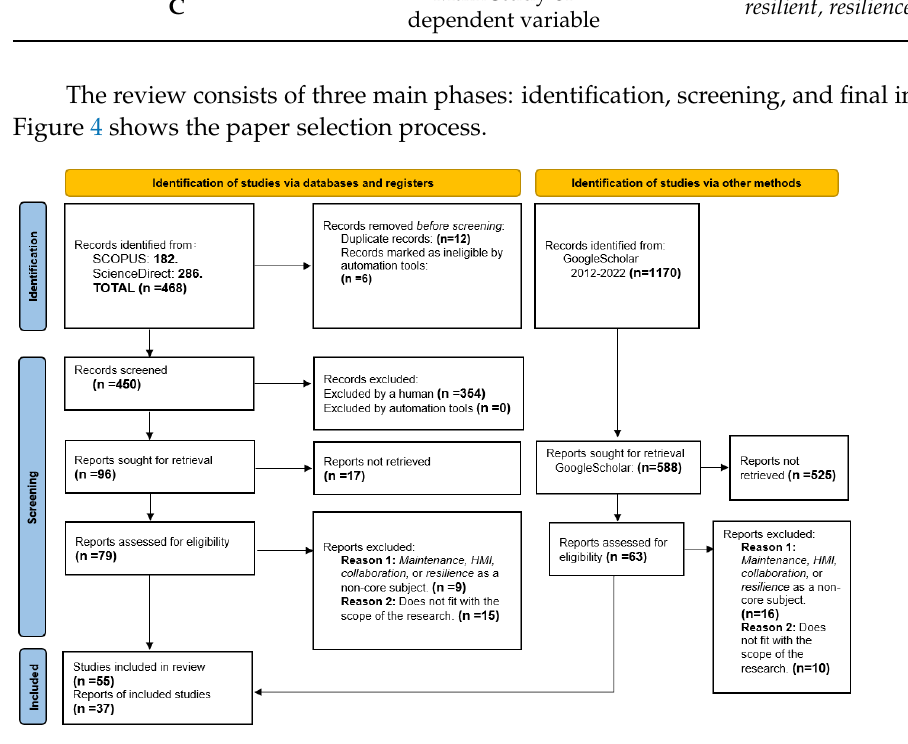
Figure 4. Flow diagram of search and selection process.